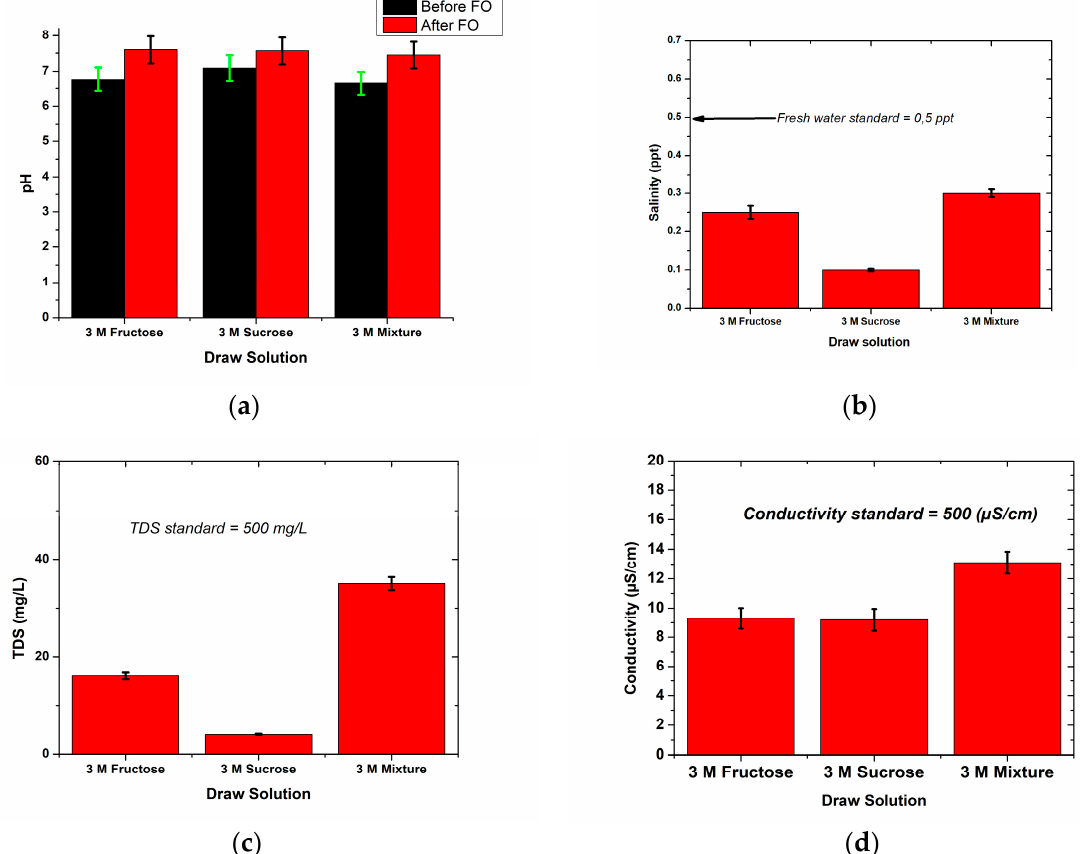
Figure 6. ( a ) pH, ( b ) salinity, ( c ) TDS, and ( d ) conductivity of the FO-processed water.